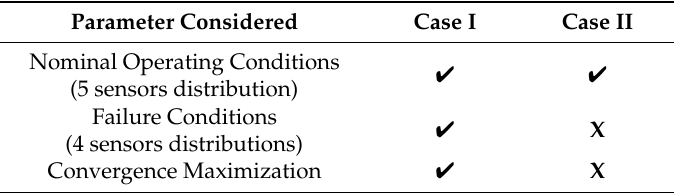
Table 3. Definition of the parameters considered for optimization in Case I and Case